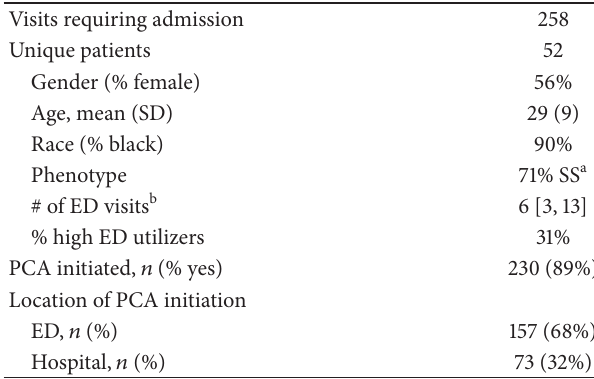
Table 1: ED visit